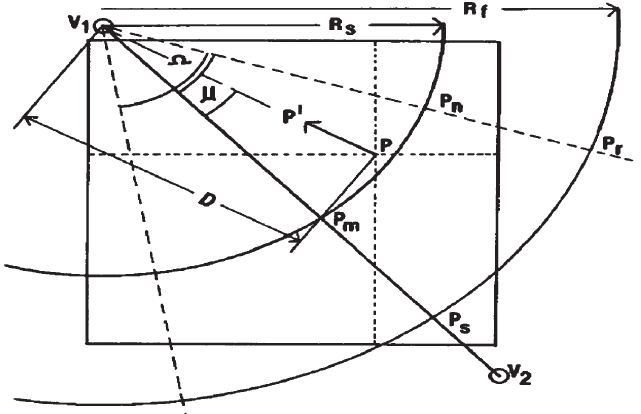
Fig. 2. Muscle vector representation [13], © 1987 ACM, Inc. Reprinted by permission, http://doi.acm.org/10.1145/37401.37405. proposed to reduce the remaining noise and to obtain facial expression motions using the smoothed data.